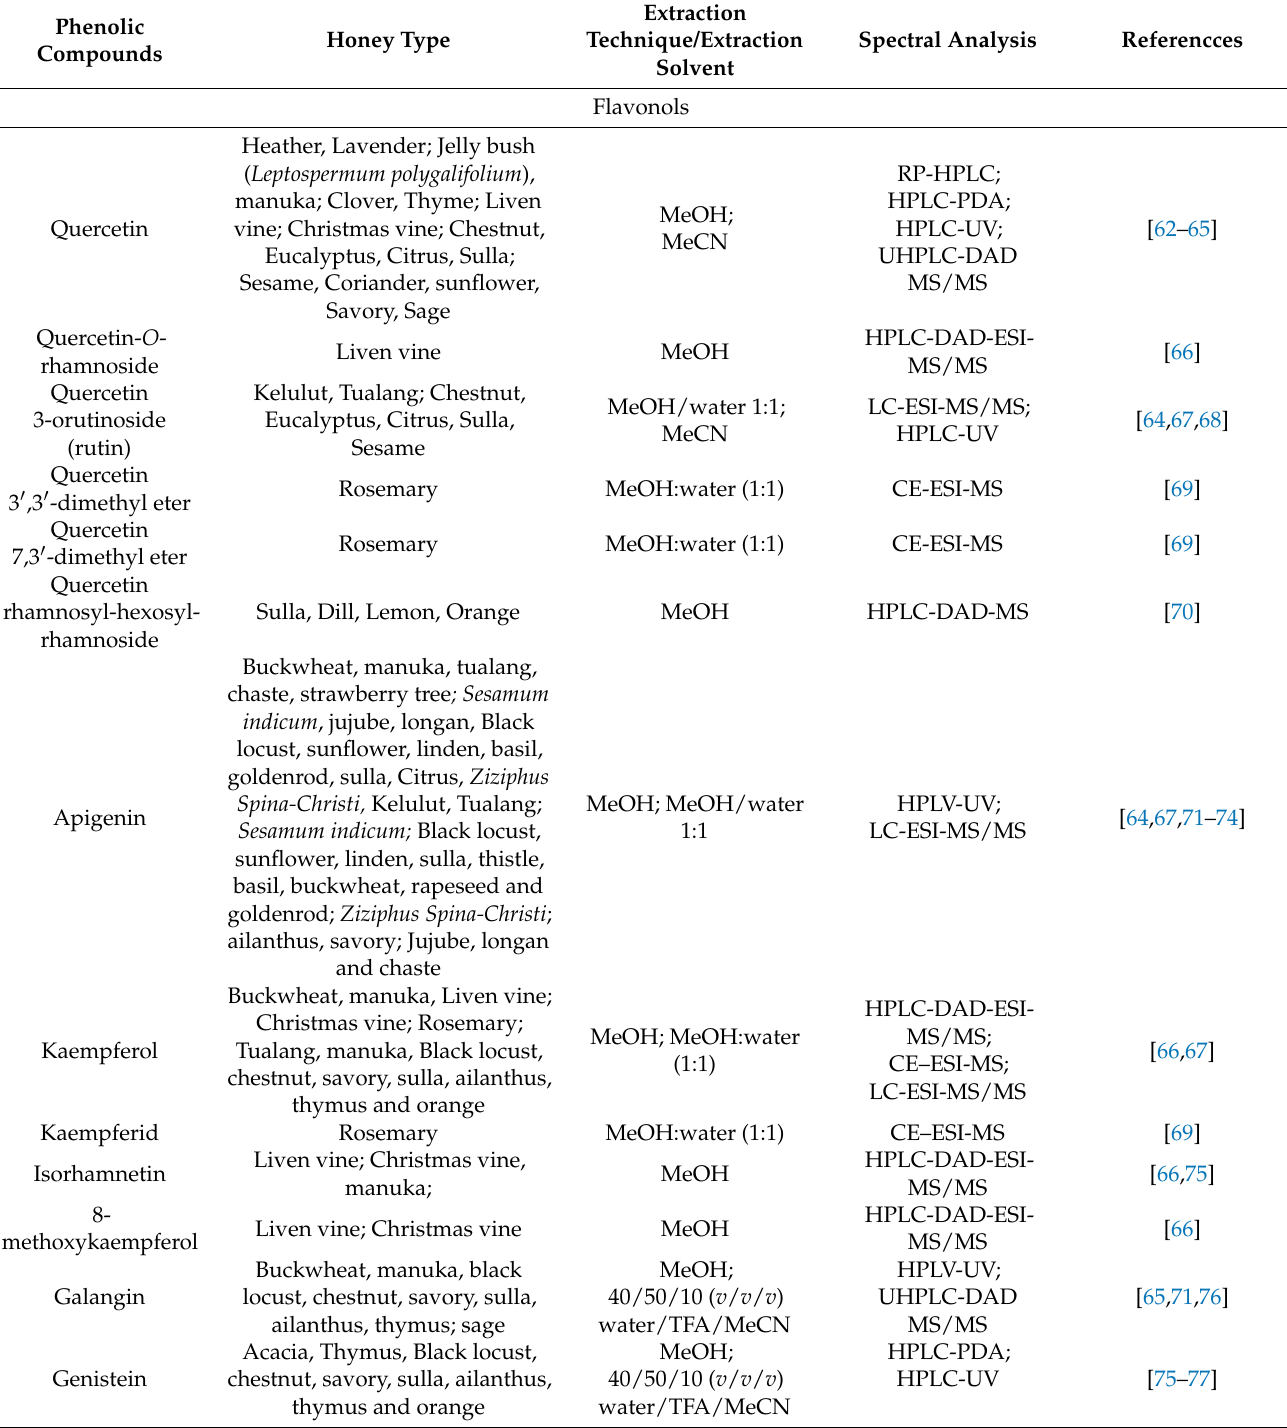
Table 2. Phenolic compounds present in monofloral